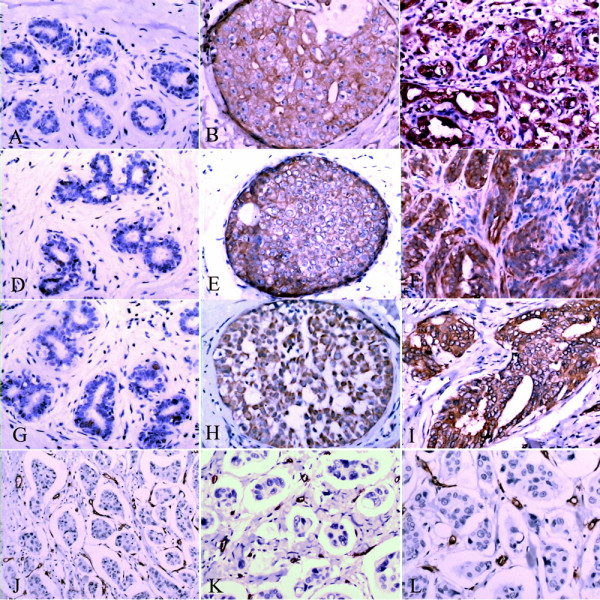
Representatives of immunohistochemical staining for eIF4E, VEGF, IL-8 and CD105 expression in breast cancer. A, slide for eIF4E expression in the adjacent normal ductal epithelial cells (negative), B, eIF4E expression in the cytoplasm of tumor cells of ductal carcinomas in situ (moderate positive), C, eIF4E expression in invasive ductal carcinoma cells (strong positive); D-F and G-I, representative panels for VEGF and IL-8 expression, respectively, in 3 types of tissues as detected for eIF4E expression in (A-C); J-L, representative slides for positive CD105 expression in 3 breast cancer specimens with invasive ductal carcinoma (×200).